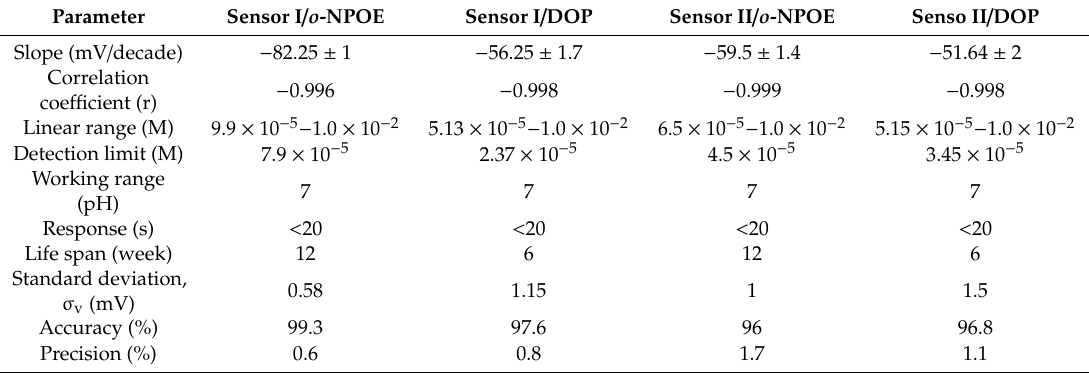
Figure 3. E ff ect of plasticizers on the potentiometric response of [neocuproin-DCPIP and methylene blue-DCPIP] membrane-based sensors. Table 1. E ff ect of plasticizer on the potentiometric characteristics of 2,6-DCPIP membrane-based